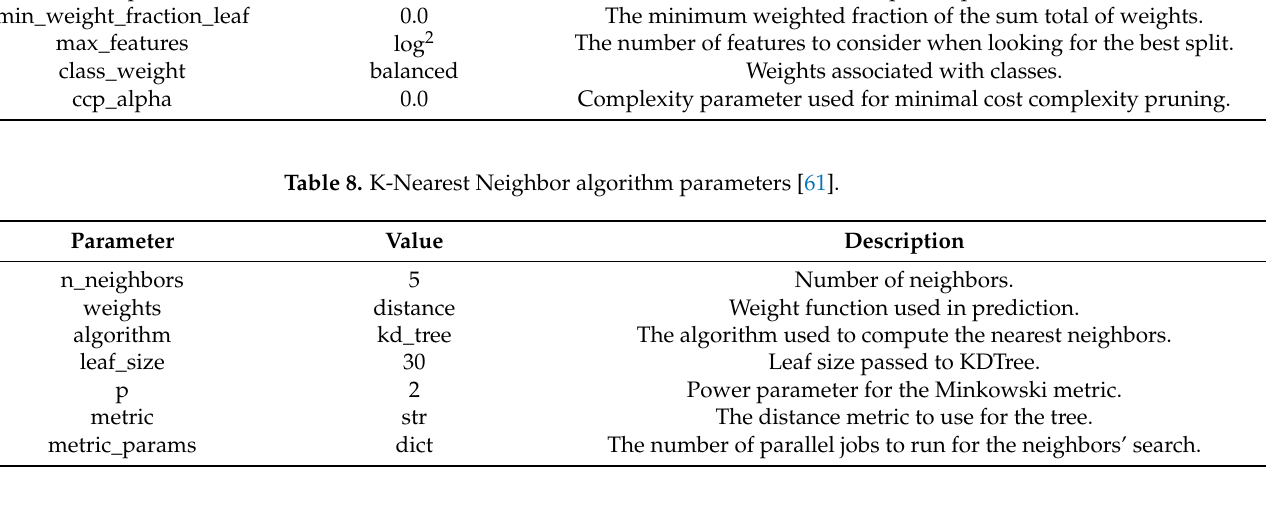
Table 9. Extreme gradient boosting algorithm parameters [62].